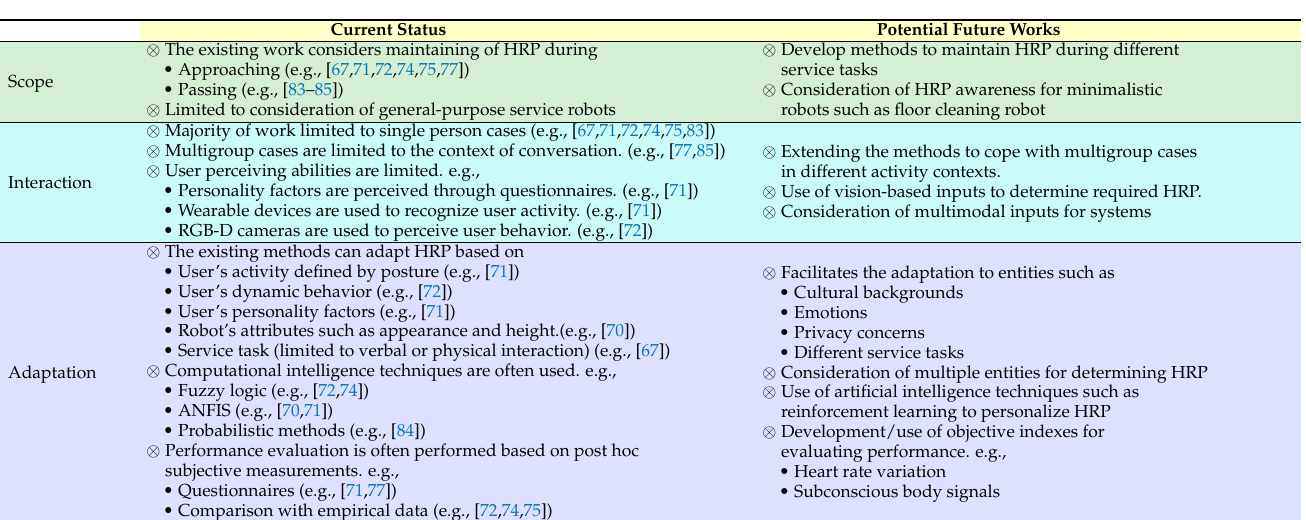
Table 3. Summary of current status and potential future work of methods for establishing HRP on service